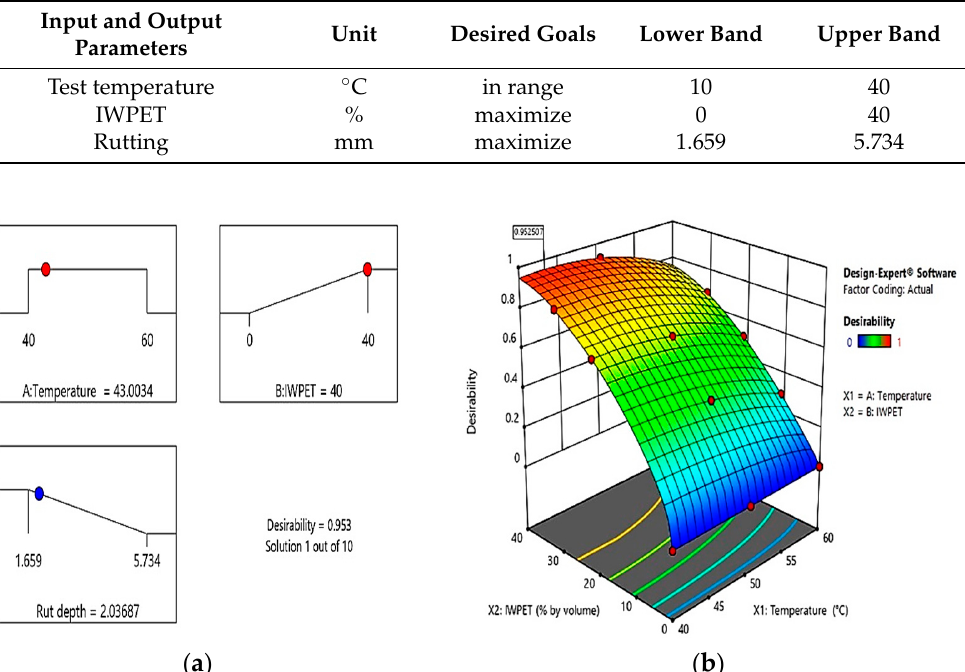
Figure 14. ( a ) Optimization ramps for the rutting response; ( b ) desirability plot.